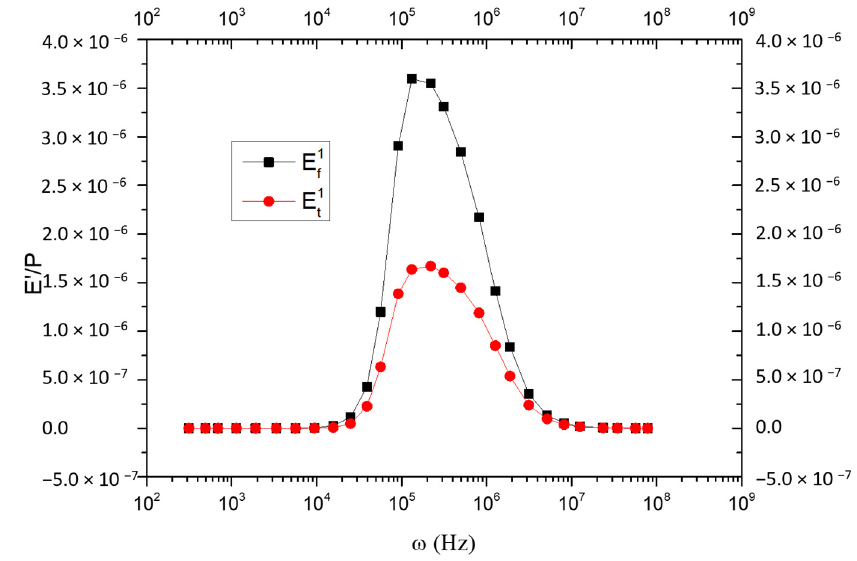
Figure 4. Comparison between normal (black line) and cancerous cells (red line) of the field E (1) as a function of the frequency of perturbation, see Equation (A6).